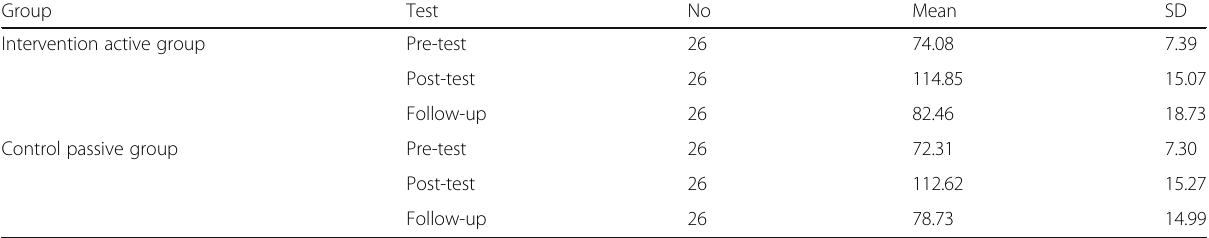
Table 1 Total social skill rating in active intervention and passive group of ASD children Group